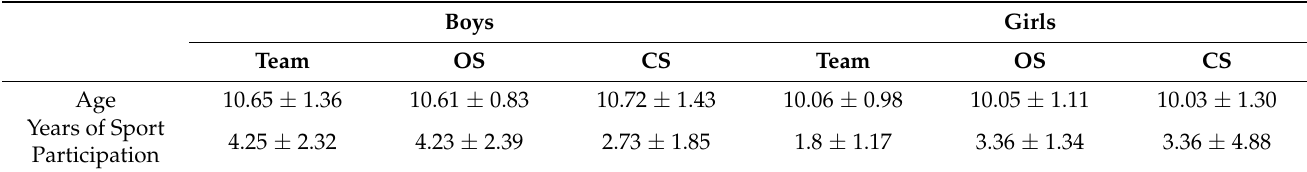
Table 1. Means (M) and standard deviations (SD) of participants’ age and years of sport participation by sport type and gender. Boys Girls Team OS CS Team